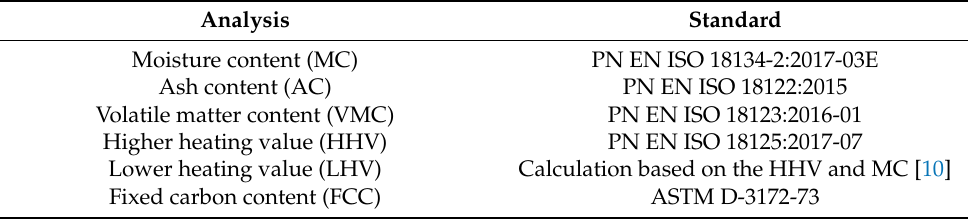
Figure 3. Laboratory devices: drying chamber KBC–65 W ( a ); biomass mill LMN 400 ( b ); thermogravimetric analyzer— Pyrolysis Biomass Gasifier No. 11/14/3 ( c ). Table 2. Analysis standards and methods of proximate